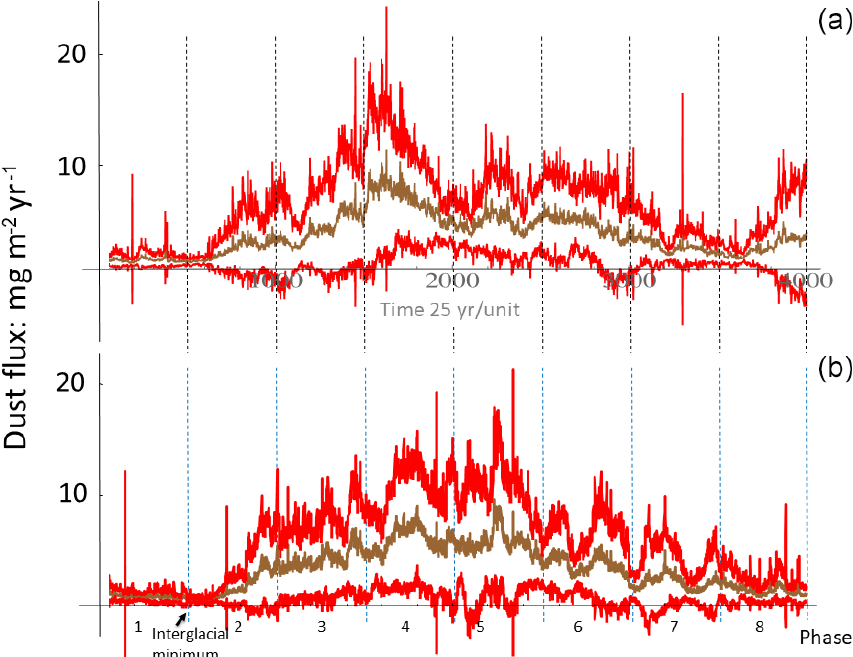
Figure 8. Panel (a) : averaging over the eight cycles at a 25-year resolution, we get the above picture: the mean is brown and the 1 standard deviation cycle-to-cycle variability is shown in red. The dashed vertical lines give a further division into 8 × 12 . 5kyr segments, the eight “phases” of the cycle. Panel (b) : the same but for the non-dimensional time. The relative position of the interglacial minimum at the first dashed line is